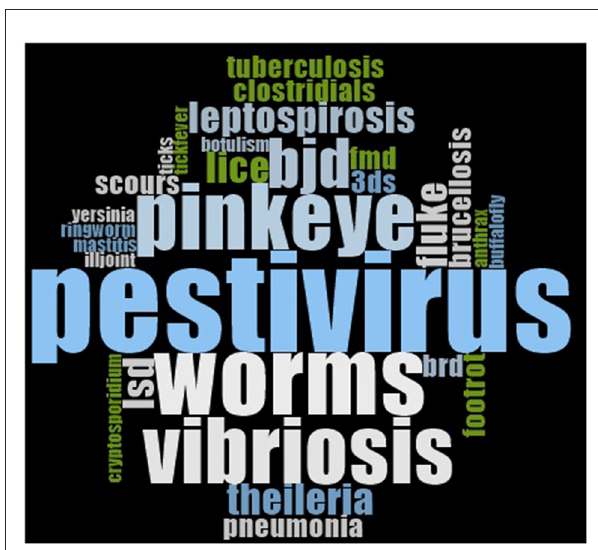
FIGURE3 Word cloud illustrating the diseases mentioned by participants during qualitative interviews discussing the prevention of endemic diseases in Australia. BJD, Bovine Johne’s disease; LSD, lumpy skin disease; 3ds, three-day-sickness; BRD, bovine respiratory disease; FMD, foot-and-mouth disease.